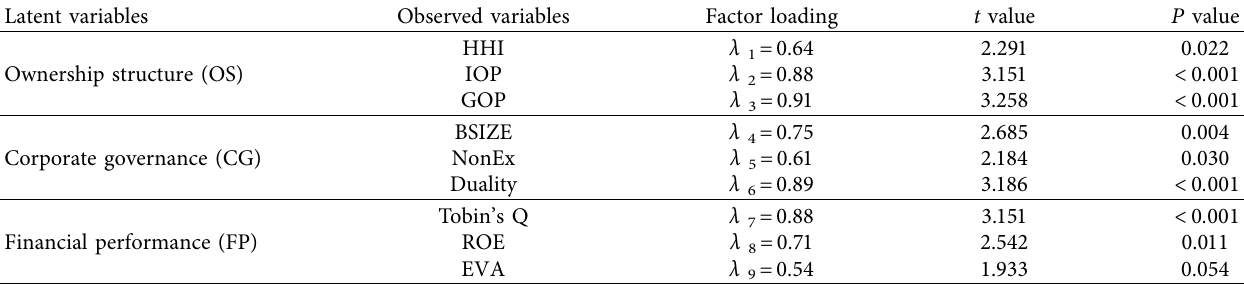
Figure 2: Measurement and structural model. Table 5: Significance of the measurement model.